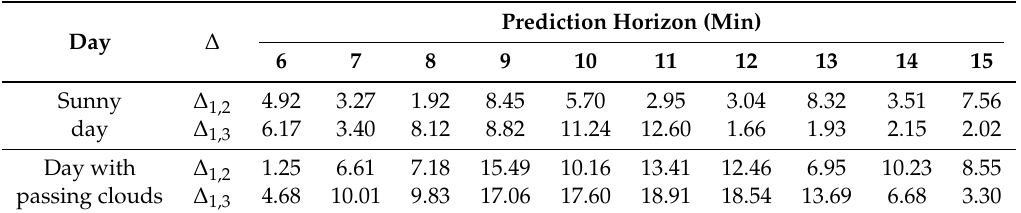
Table 6. Index ∆ of the performance for the differences between Scenarios 2 and 3 on a sunny day and a day with passing